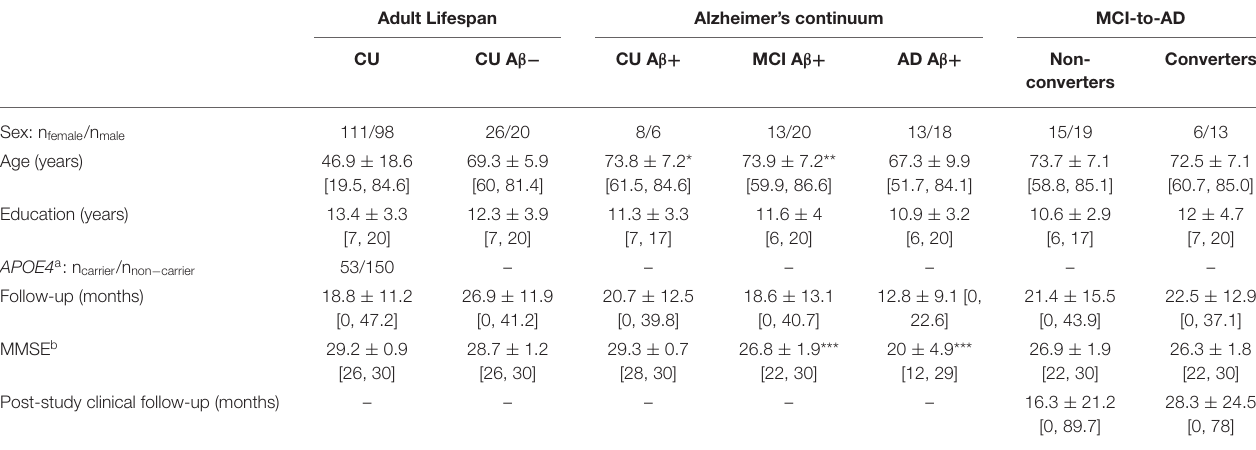
TABLE 1 | Demographics of the study sample. Adult Lifespan Alzheimer’s